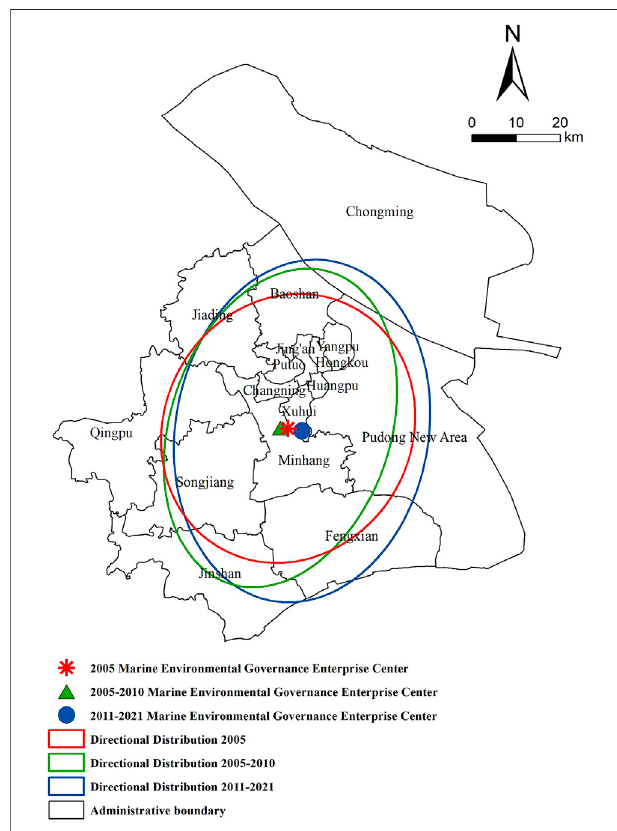
FIGURE 3 | Standard deviational ellipse of resource distribution of MEG entities and institutions in Shanghai from 2005 to 2021.